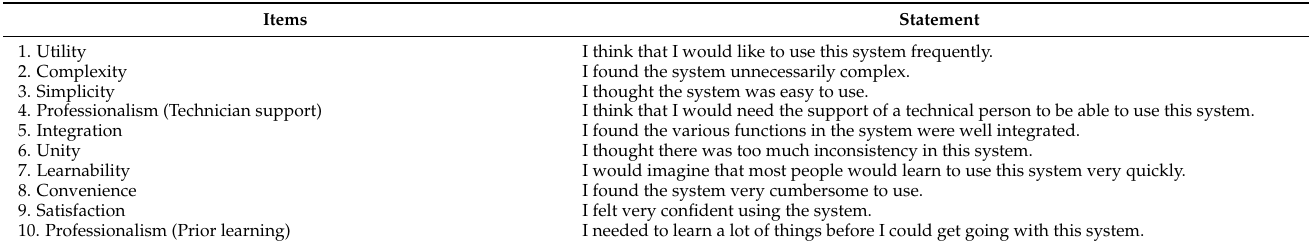
Table 2. System Usability Scale (SUS) questionnaire.